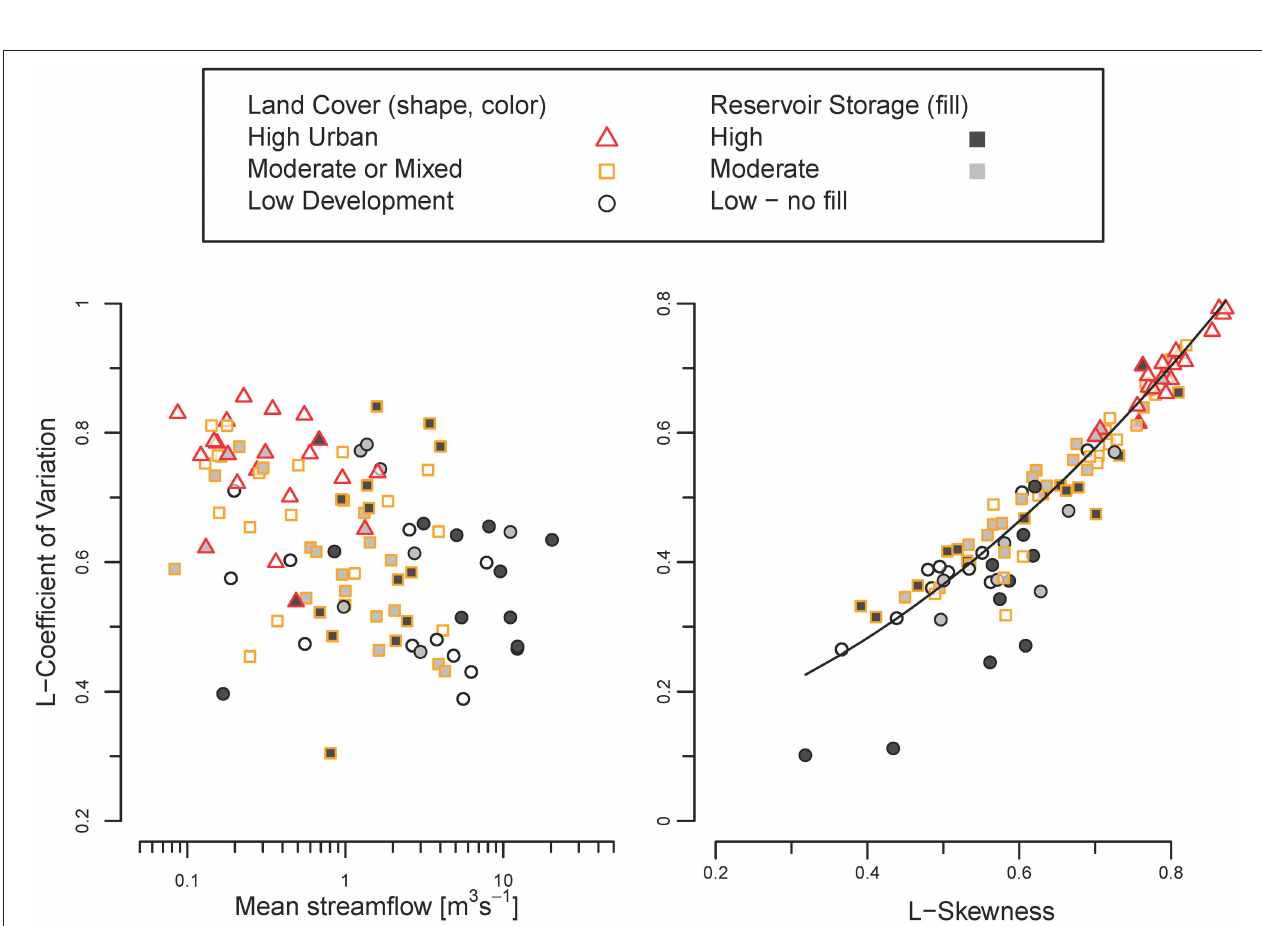
FIGURE 8 | Linear moments for the instantaneous streamflow distributions of 100 streams in the southeastern United States. Line shows the relation between L-Skewness and L-Coefficient of Varation for generalized extreme value distributions.